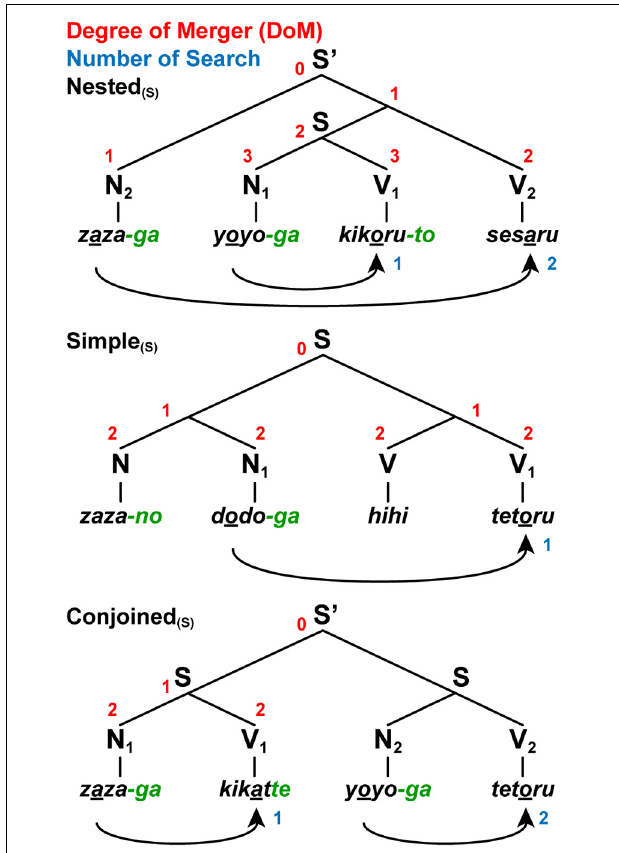
FIGURE 4 | A paradigm for testing various sentence structures. We tested three sentence conditions with short [(S) as a subscript] jabberwocky sentences: Nested ( S ) , Simple ( S ) , and Conjoined ( S ) . Note the syntactic structures of these jabberwocky sentences are same as those of real sentences in Figure 3 . The digits shown in red and blue denote the DoM for each node and “number of Search,” respectively. We also tested the long stimuli with six